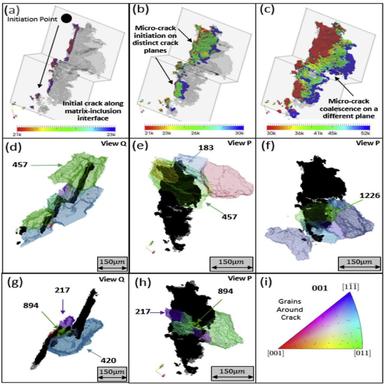
Division of the crack progression into three parts, (a) growth along the inclusion-matrix interface, (b) micro-cracks growth on two distinct planes between 21k and 30k cycles, (c) micro-cracks coalescence and growth on a bridge between 30k to 52k cycles. Selecting specific grains for further discussion: (d) intragranular SFC growth in Grain 457, (e) crack arrest at Grain 183, and (f) crack propagation along Grain 1226. Intergranular crack growth as shown in two views (Q and P, see d) and e) corre